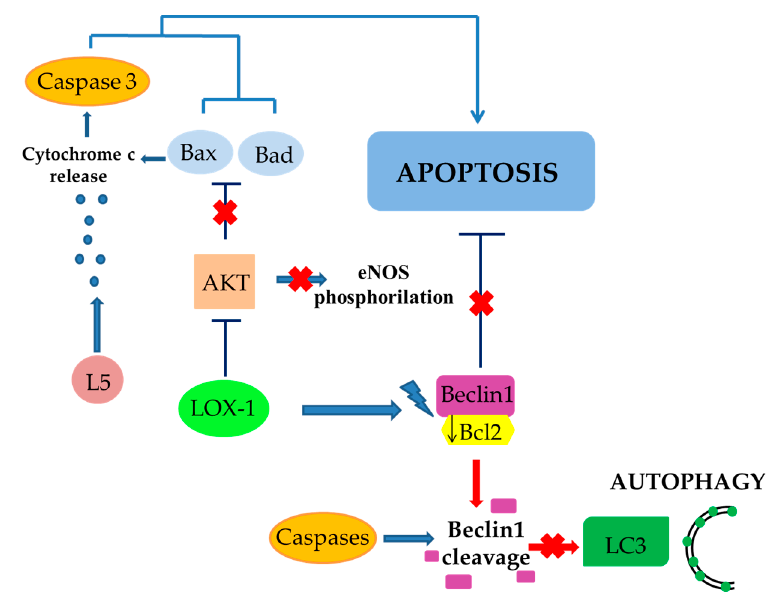
Figure 4. Role of LOX-1 activation in the crosstalk between apoptosis and autophagy in endothelial cells.